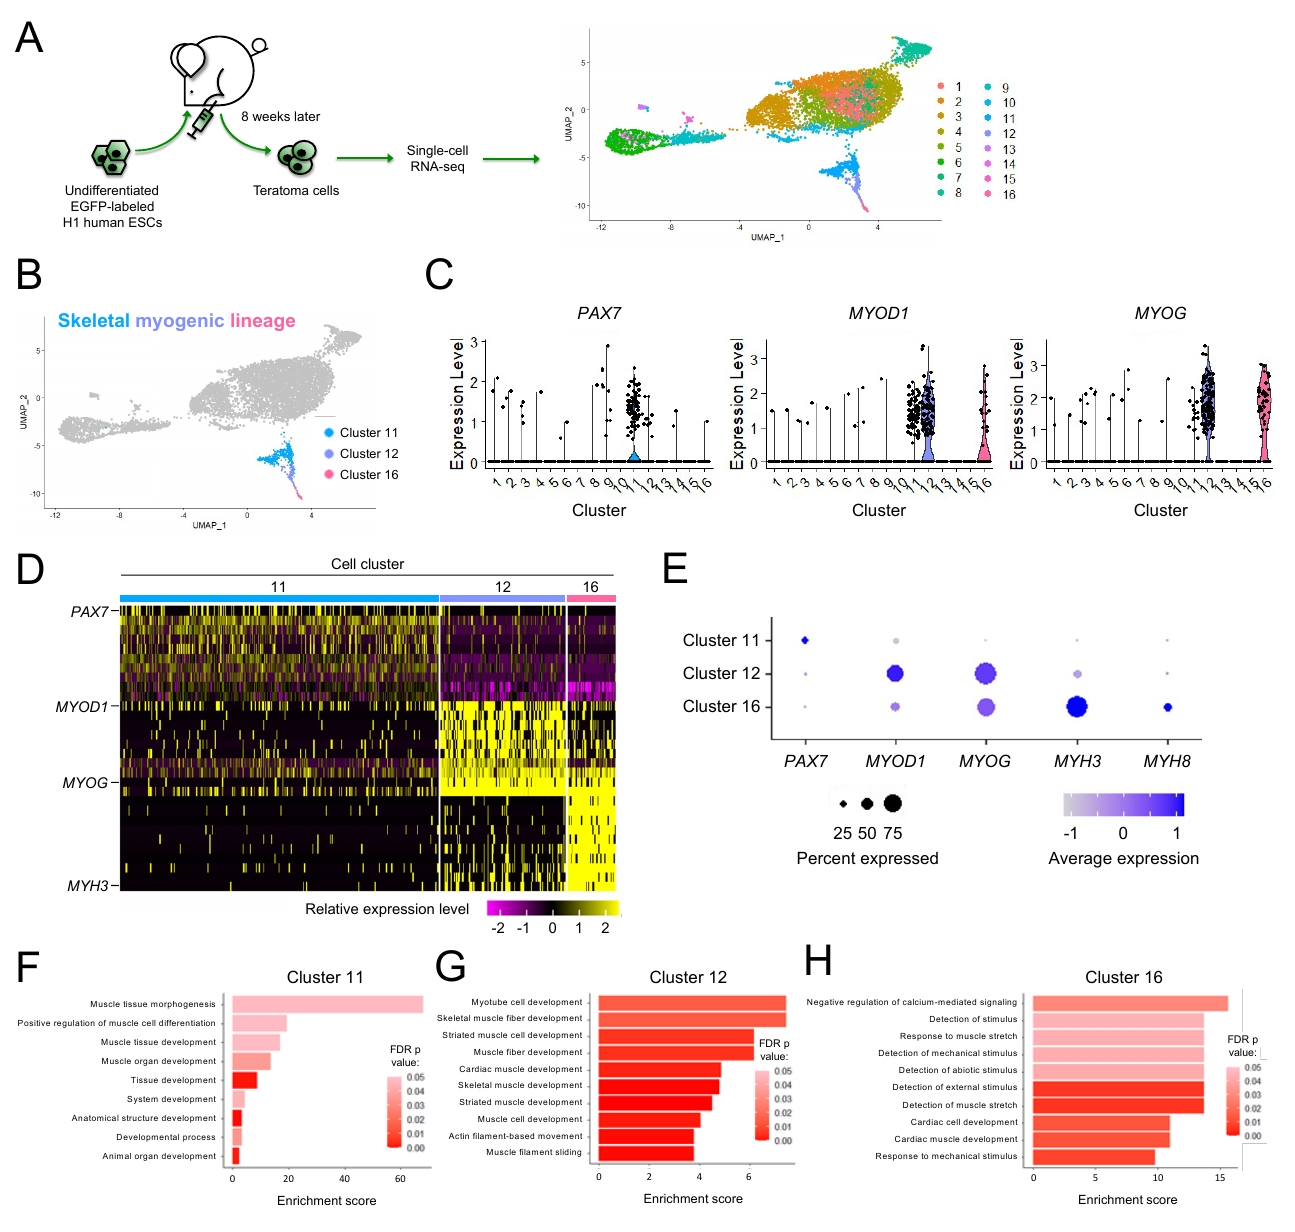
Figure 1. Skeletal myogenic cells are found in human H1 ESC-derived teratomas. ( A ) Schematic illustrating single-cell RNA-seq analysis of human H1 ESC-derived teratoma cells. ( B ) Cells with expression profiles resembling the skeletal myogenic lineage are found in Clusters 11, 12, and 16. ( C ) Violin plots of skeletal myogenic regulatory factors PAX7, MYOD1 and MYOG showing that they primarily express in Clusters 11, 12, and 16. ( D ) Heatmap showing within the three skeletal myogenic clusters the top 10 enriched genes, among them several key myogenic factors. ( E ) Dot plot showing the enrichment of several skeletal myogenic regulatory factors in Clusters 11, 12, and 16. ( F – H ) Gene Ontology biological processes that are enriched are shown for Cluster 11 ( F ), Cluster 12 ( G ), and Cluster 16 ( H ). Significance was determined using false discovery rate-corrected (FDR) p values at <